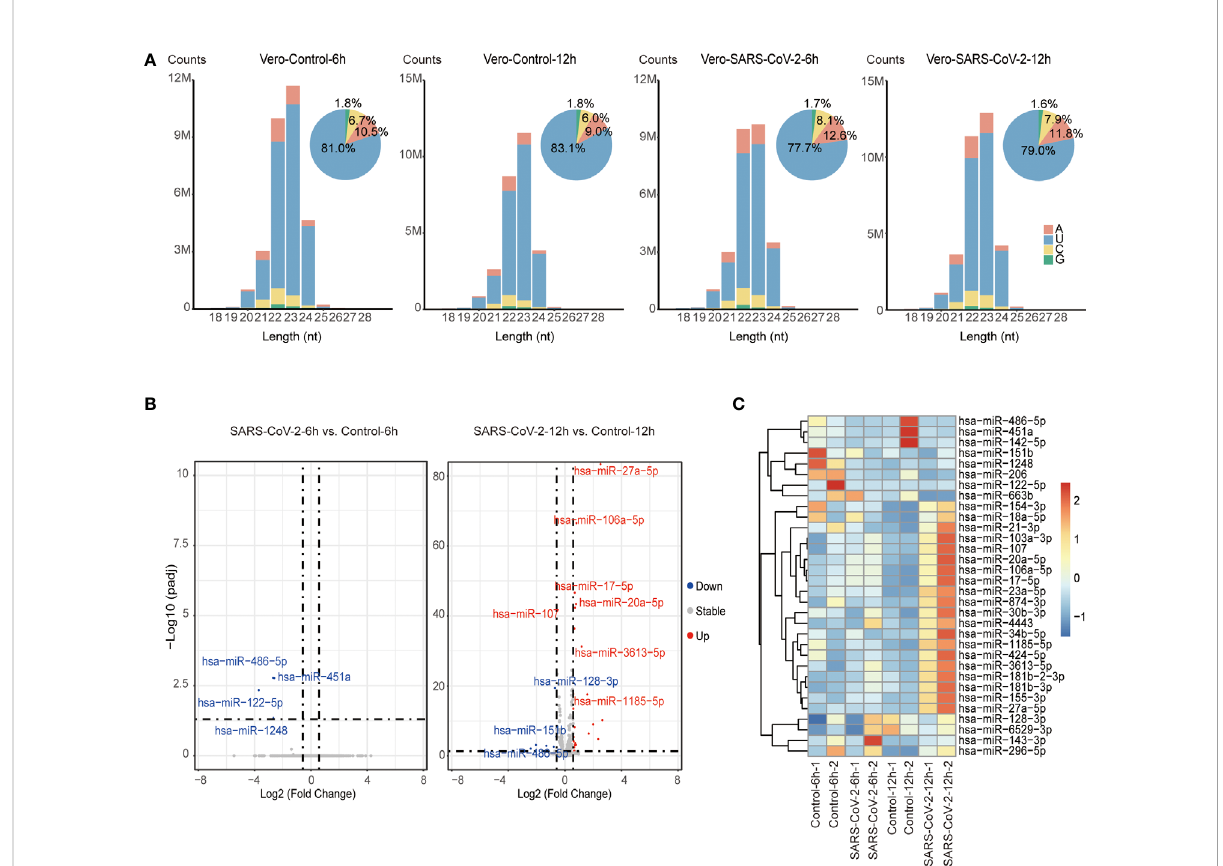
FIGURE 2 Identi fi cation of DE miRNAs in SARS-CoV-2 infected Vero cells. (A) Size distribution of miRNA reads in control and virus-infected (6 hpi/12 hpi) Vero cells. miRNA reads are classi fi ed by length and are shown as read counts. Pie plots represent miRNAs initiated with A/U/C/G in control and virus-infected Vero cells. (B) Volcano plot showing the differentially expressed miRNAs in Vero cells infected with SARS-CoV-2 6 hpi/12 hpi vs. controls (n=2). Red dots and blue dots respectively represent up-regulated and down-regulated miRNAs (fold change ≥ 1.5, adjusted P value ≤ 0.05). (C) Heatmap of human miRNA expression in control and virus-infected (6 hpi/12 hpi) Vero cells. Only miRNAs that are signi fi cantly changed are shown in